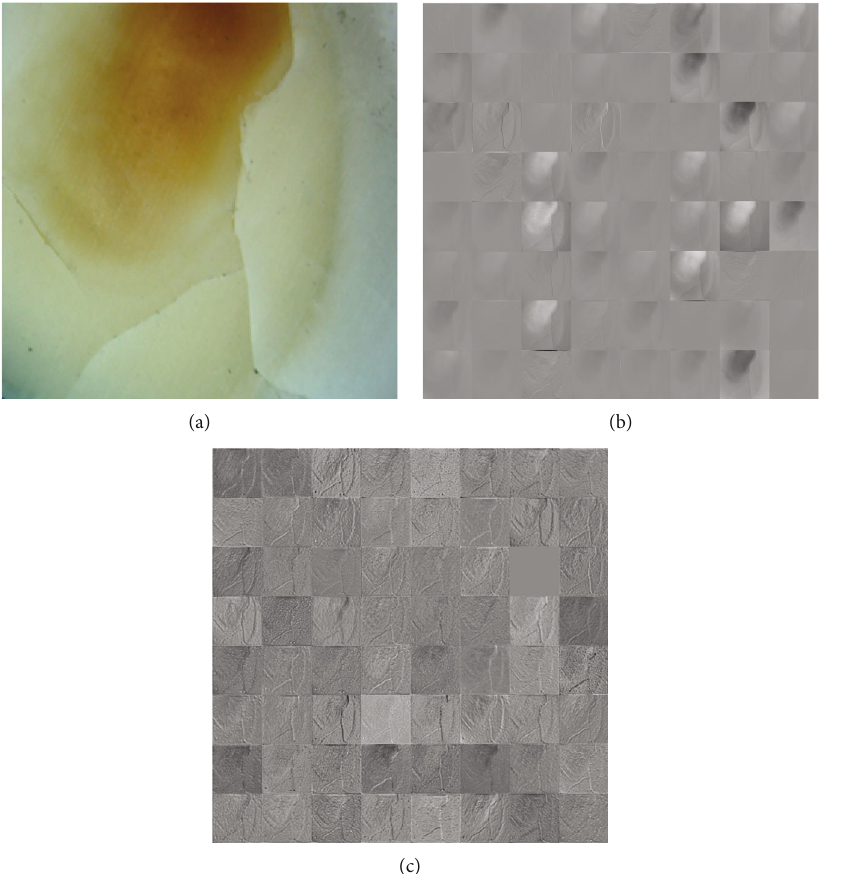
Figure 7: Visualization of features: (a) raw images; (b) feature visualization after the fi rst convolution (64 images); and (c) feature visualization after the 31st convolution layer (64 images).